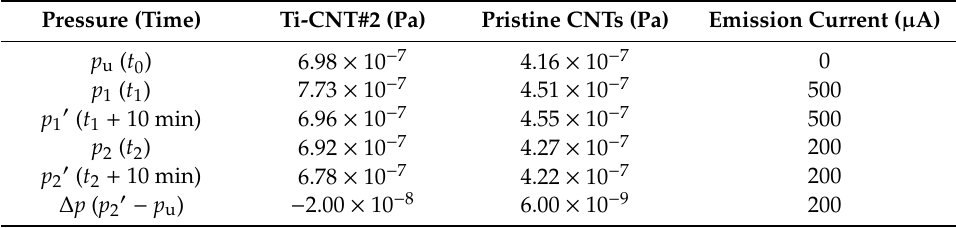
Table 1. Pressure variation during the degassing of Ti-CNTs #2 and pristine